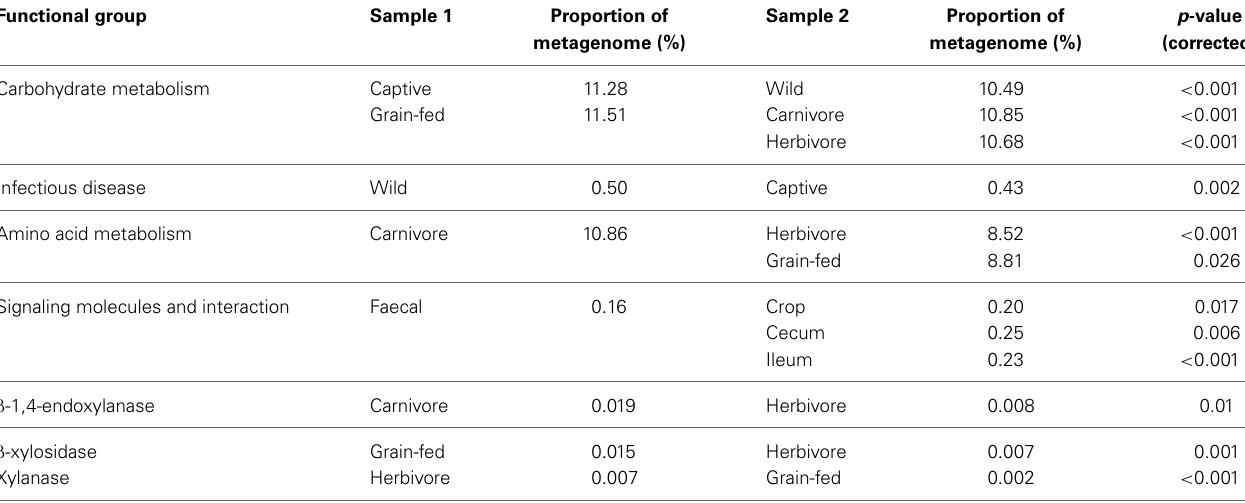
Table 4 | Summary of key findings in differences between predicted